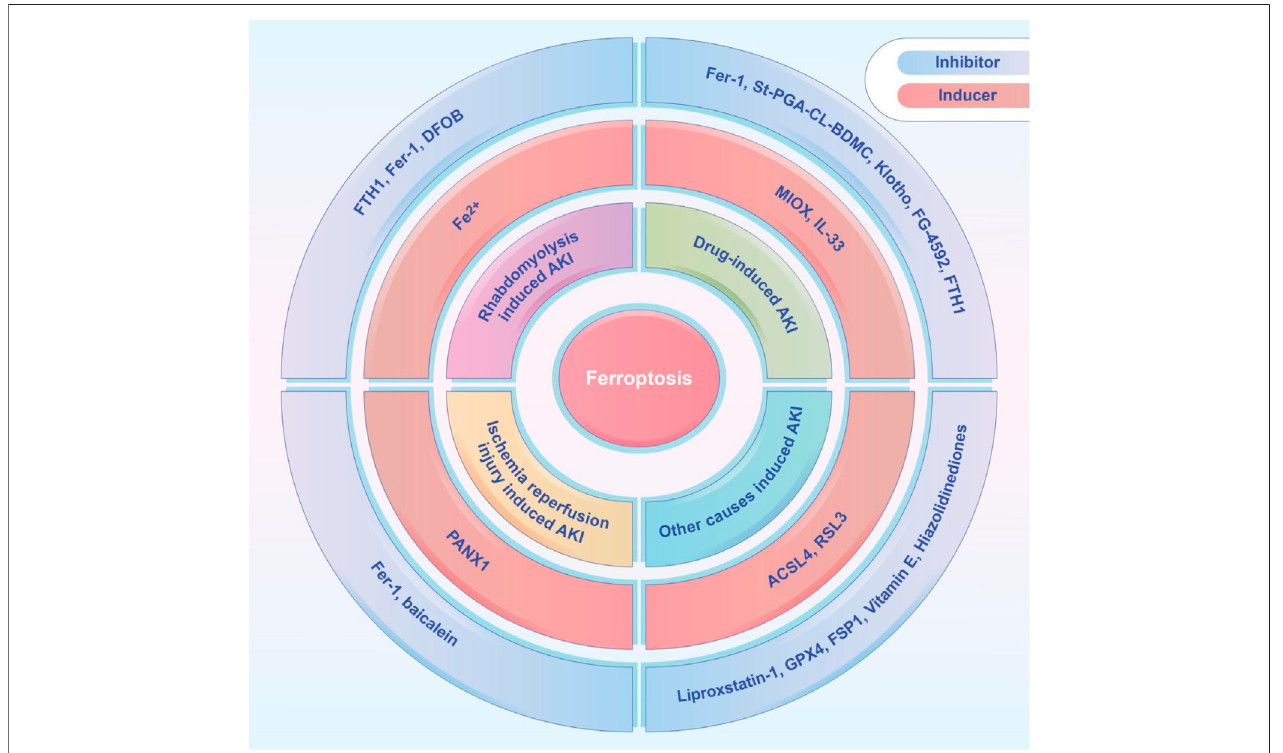
FIGURE2| TheferroptosisinducersandinhibitorstestedinanimalmodelsofAKI,includingrhabdomyolysisinducedAKI,drug-induced AKI,ischemia-reperfusion induced AKI, and other causes induced AKI. ACSL4, acyl-coenzyme A synthetase long chain family member 4; DFOB, desferrioxamine B; FTH1, ferritin heavy chain 1; Fer-1,ferrostatin-1;FG-4592,roxadustat;FSP1,ferroptosissuppressorprotein1;GPX4,glutathioneperoxidase4;IL-33,interleukin33;MIOX,myo-inositoloxygenase; PANX1, pannexin1; St-PGA-CL-BDMC, star-shaped polyglutamate conjugate of